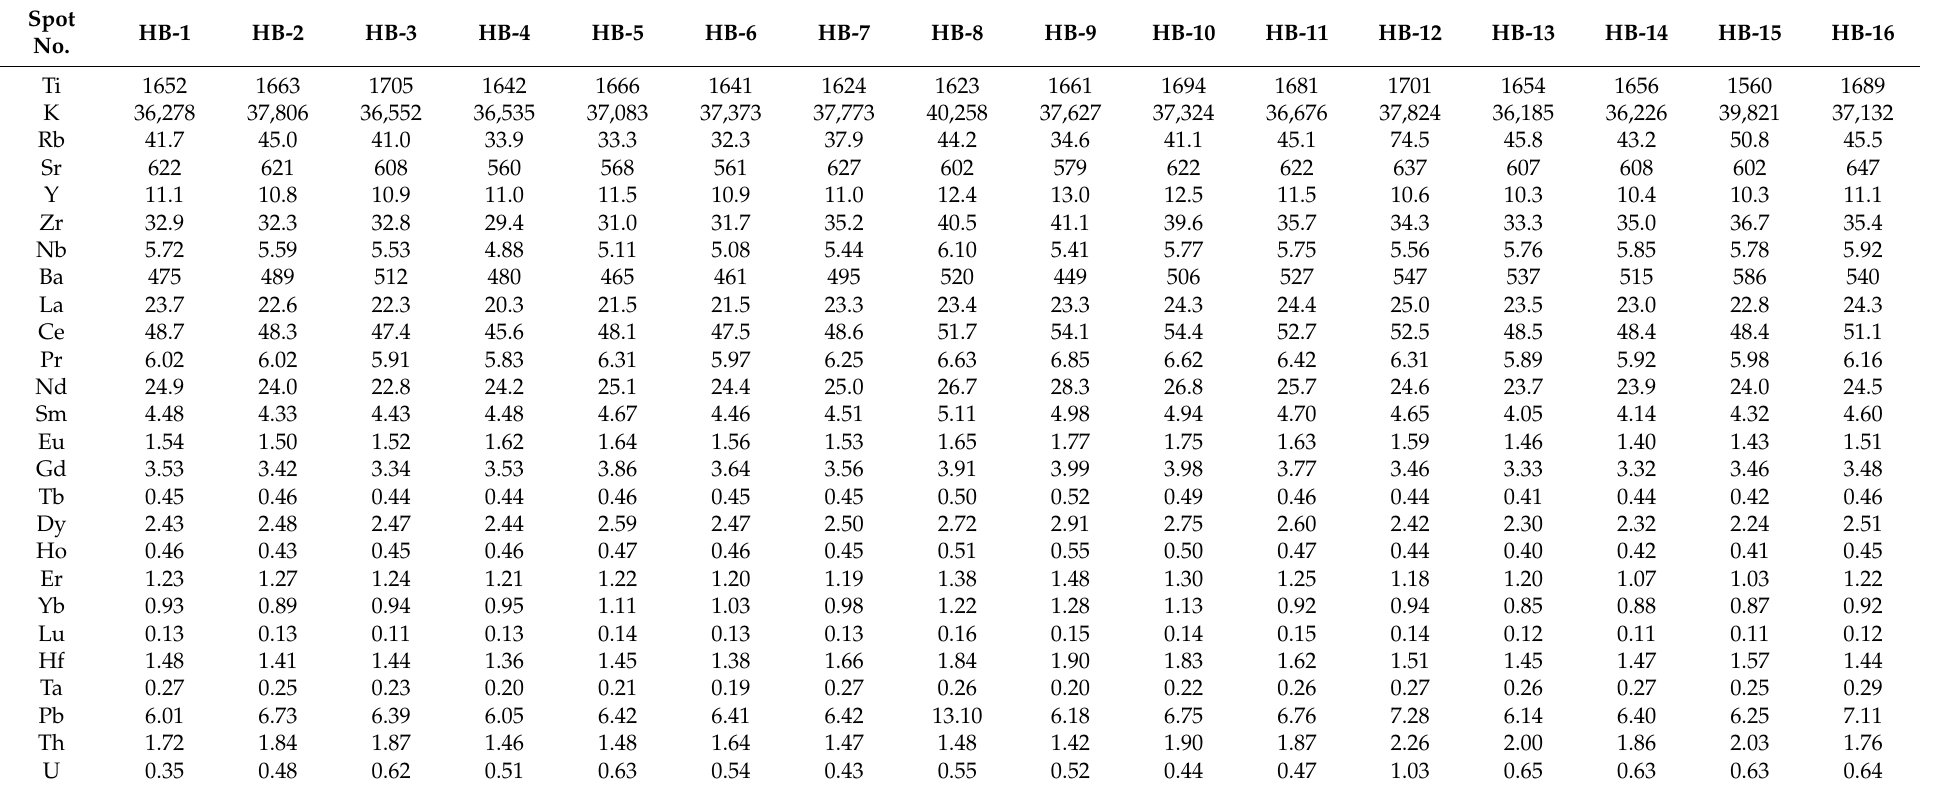
Table 4. Melt compositions (ppm) in equilibrium with the amphiboles in the Paleoproterozoic Gaositai